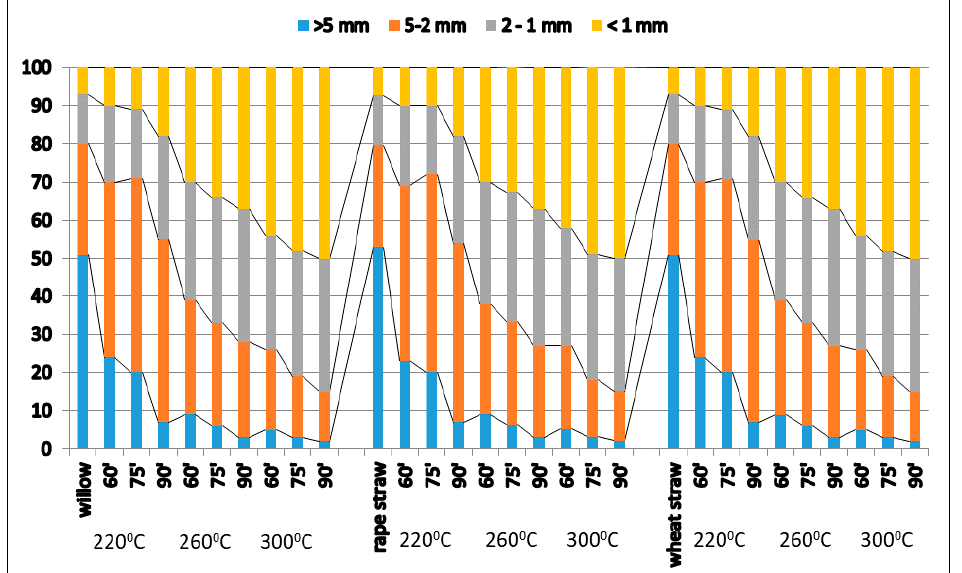
Figure 2. Grain size distribution in biomass and torrefied products depending on the parameters of the torrefaction